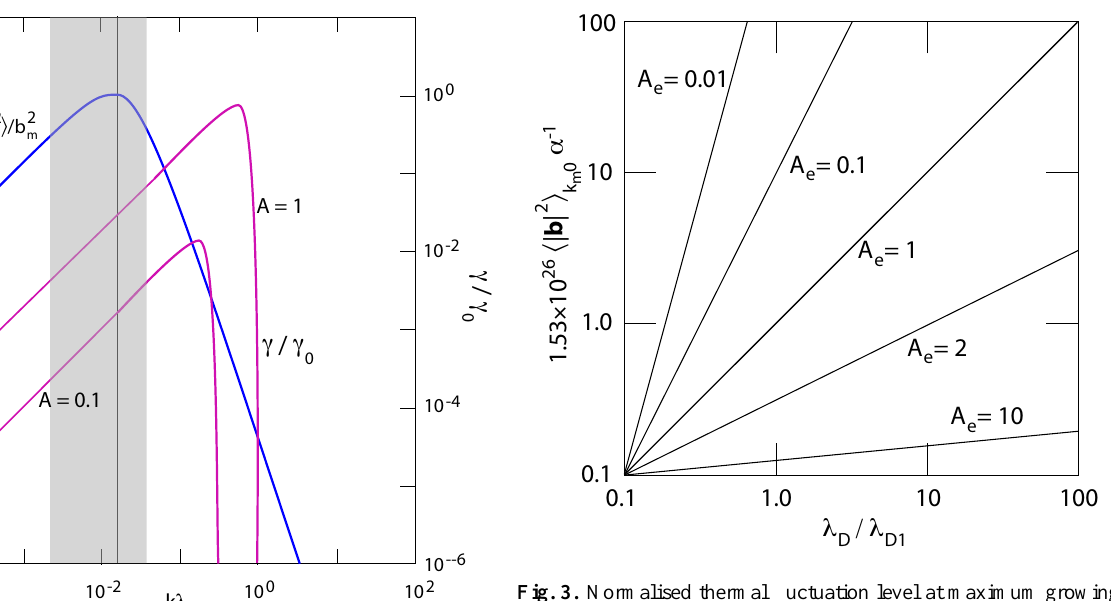
Fig. 3. Normalised thermal fluctuation level at maximum growing Weibel wave number k m as function of Debye length λ D . The fluc- tuations are normalized to their value at T e = 1eV, N = 1cm − 3 . The Debye normalisation is taken to the Debye length λ D1 at these numbers. As suggested by Fig. 2, the initial fluctuation level from where the maximum unstable Weibel mode grows decreases ∼ A − 1 √ A . Since the because of its dependence on k m , which increases as spectral energy density of fluctuations decreases ∼ k − 3 , the